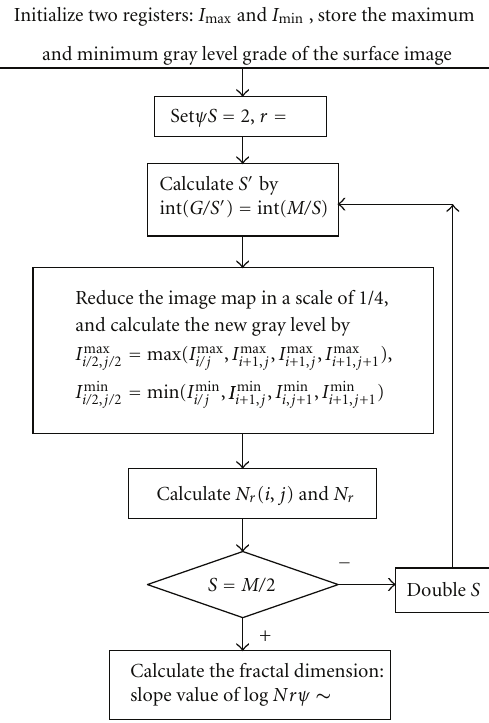
Figure 1: Flow chart for calculating fractal